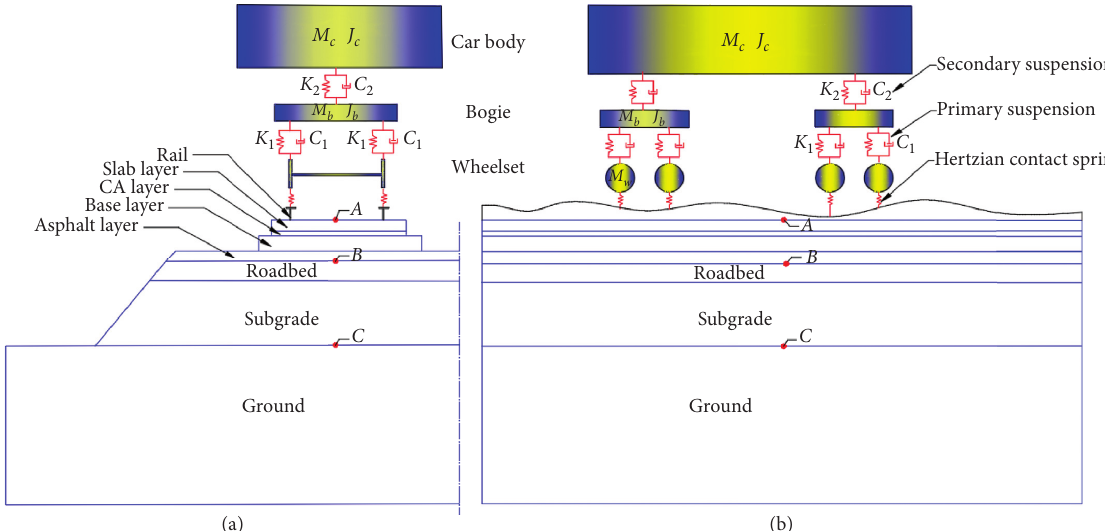
Figure 1: Representative view of the train-track-ground model together. Longitudinal view (a) and transversal view (b). Table 1: Parameters of CRH3 high-speed train [26].